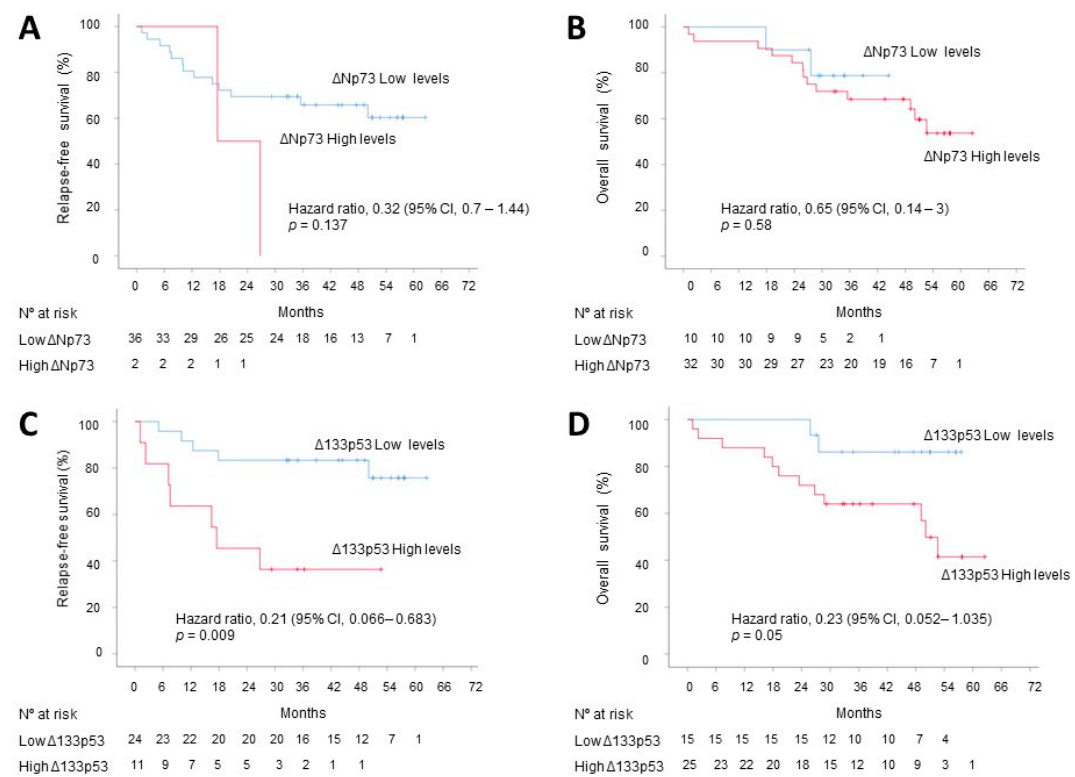
Figure 7. Kaplan–Meier estimates of DFS and OS. Influence of EVs’ content of Δ Np73 on DFS ( A ) and OS ( B ), and EVs’ content of Δ 133p53 on DFS ( C ) and ( D ) on OS. Tick marks indicate censored data. Low and high levels of Δ Np73 and Δ 133p53 were classified according to the selected cut-offs.